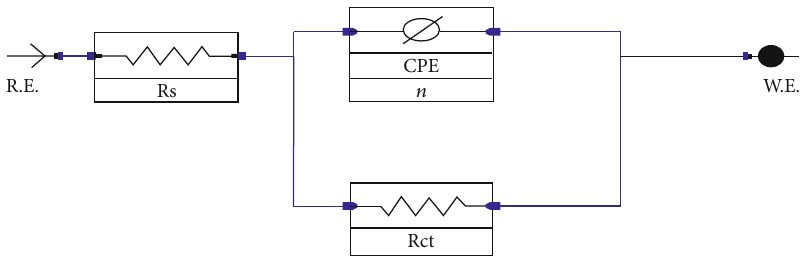
Figure 3: Adopted equivalent circuit model for assessing the results of electrochemical impedance spectroscopy. Table 4: EIS parameters and corrosion inhibition e ffi ciency of A515 Grade 70 carbon steel in 1M NaCl solution at 303K in the absence and presence of various concentrations of CMSE.